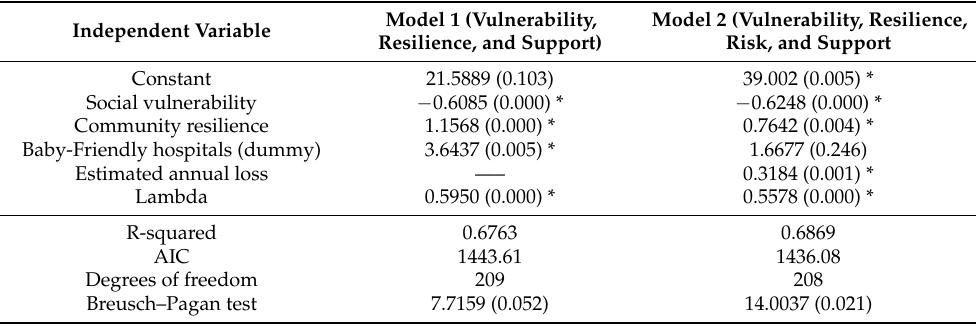
Table 3. Spatial error models results for the relationship between breastfeeding initiation and community risk, vulnerability, and resilience